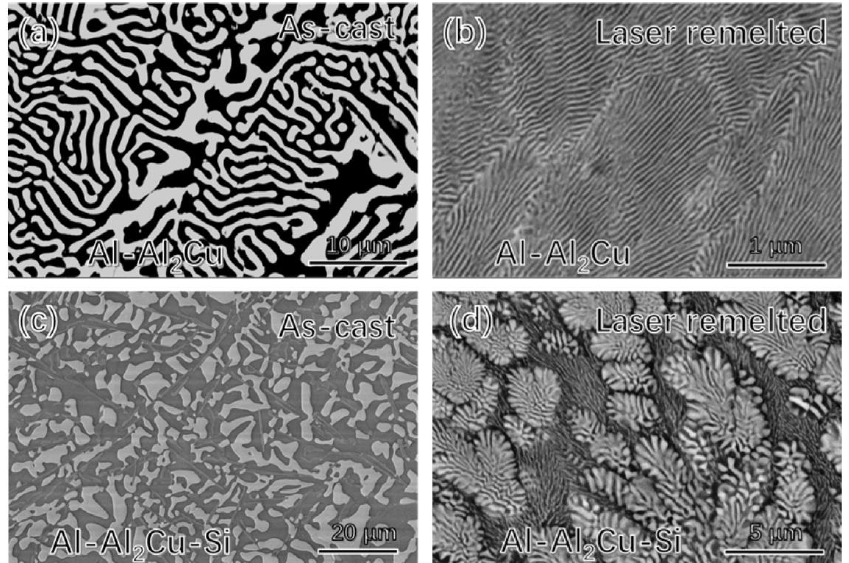
Figure 1. Backscattered electron (BSE) images of the microstructure of as-cast Al – Al 2 Cu and Al – Al 2 Cu – Si eutectics; ( a ) as-cast Al – Al 2 Cu; ( b ) laser-remelted Al – Al 2 Cu; ( c ) as-cast Al – Al 2 Cu – Si; ( d ) laser-remelted Al – Al 2 Cu – Si.